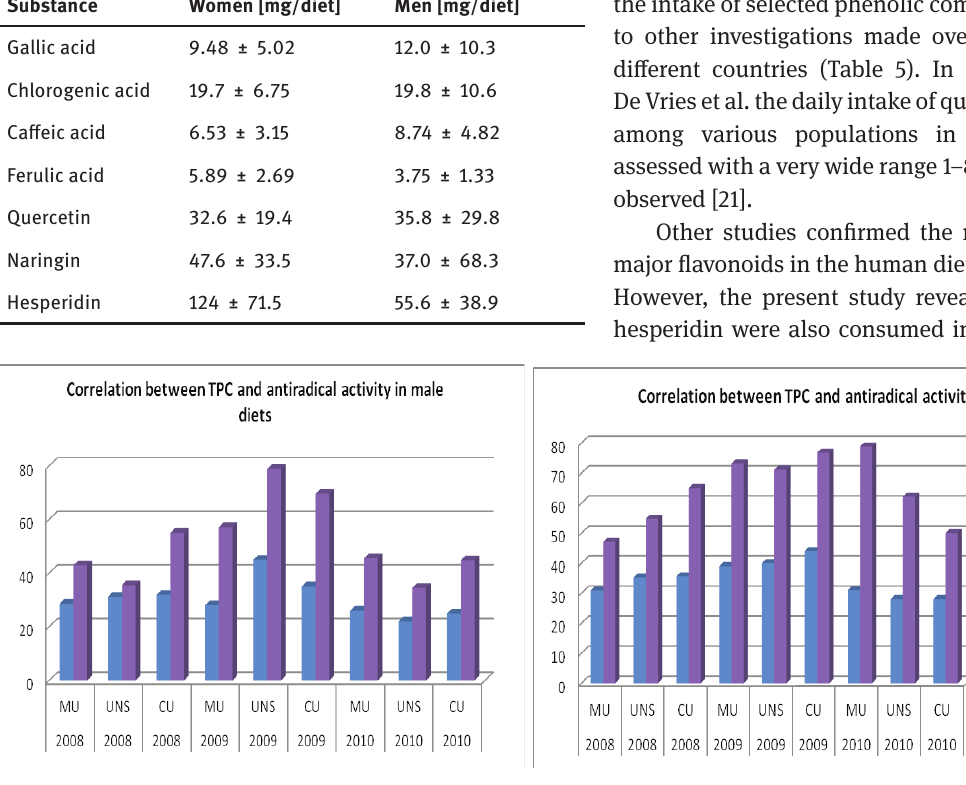
Figure 2: Correlation of TPC (total polyphenols content) and DPPH free radical scavenging assay (% of inhibition) (MU – Medical